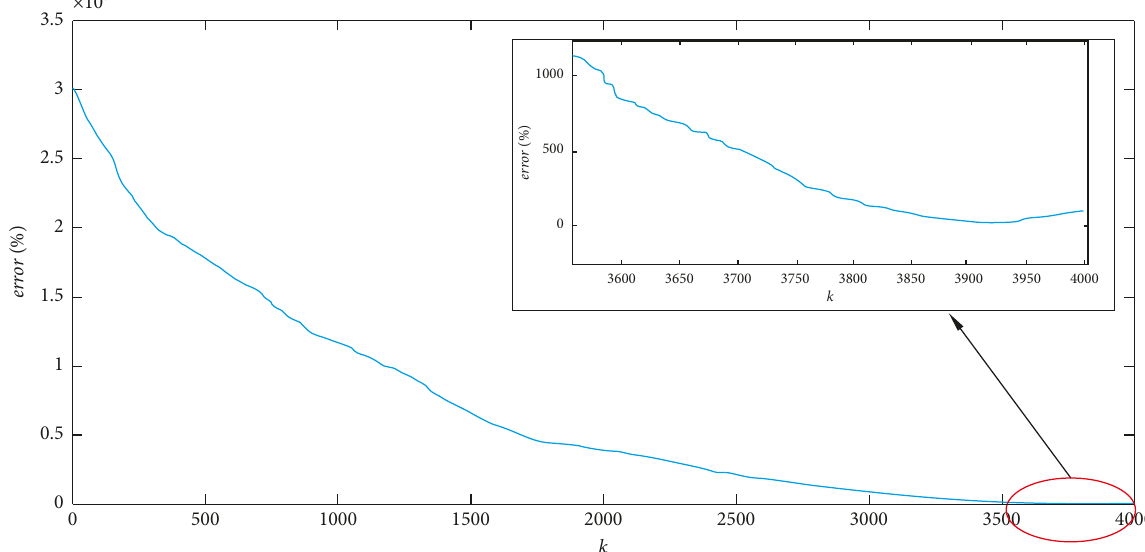
Figure 2: The relationship between the relative error of identifying load and the order of truncation k .